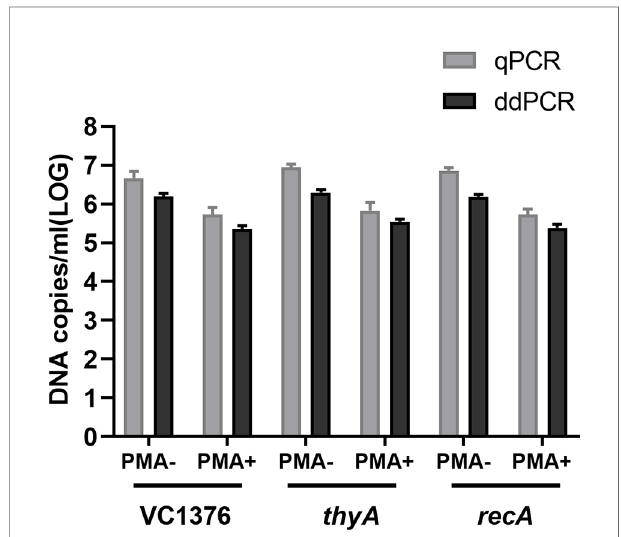
FIGURE 1 | Quanti fi cation of total and viable cells (in DNA copies/mL) using genes VC1376, thyA , and recA at day 70 during viable but non-culturable (VBNC)-state development of Vibrio cholerae strain C6706. Total cells were measured without PMA treatment (PMA − ) and viable cells were measured after PMA treatment (PMA+). qPCR, quantitative PCR; ddPCR, droplet digital PCR. Error bars represent the mean and standard error of measurement.